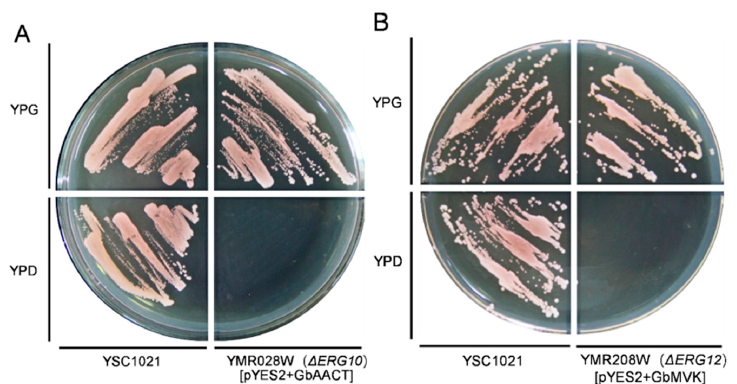
Figure 5. Functional complementation for the growth of haploid disrupted strains Δ erg10 complemented with GbAACT ( A ) and Δ erg12 complemented with GbMVK ( B ). The strains were grown on YPD and YPG at 30 °C for 3 days with the exception of Δ erg10 with GbAACT and Δ erg12 with GbMVK . 2.5. Transcript Level of the Gene Expression Pattern of GbAACT and GbMVK in Different Tissues of G. biloba To present, reports corresponding to the AACT and MVK of G. biloba have been inexistent. To determine the expression patterns of GbAACT and GbMVK genes among different tissues in G. biloba , total RNA was extracted from roots, stems, leaves, female flowers, male flowers, and fruit, and cDNA was synthesized as mentioned above. qRT-PCR (Real-time quantitative reverse transcription PCR) was performed for GbAACT and GbMVK (Figure 6).